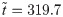
Test 4: Comparison between FOM and DL-ROM solutions for different testing-parameter instances.FOM solution (left), DL-ROM solution with n = 4 (center) and relative error ϵk (right) for the testing-parameter instances μtext = (12.9 · 0.1125 cm2/ms, 12.9 · 0.0563 cm2/ms, 0.1875) (top) and μtext = (12.9 · 0.1475 cm2/ms, 12.9 · 0.0737 cm2/ms, 0.2375) (bottom) at t˜=319.7 ms. The maximum of the relative error ϵk is about 10−3.